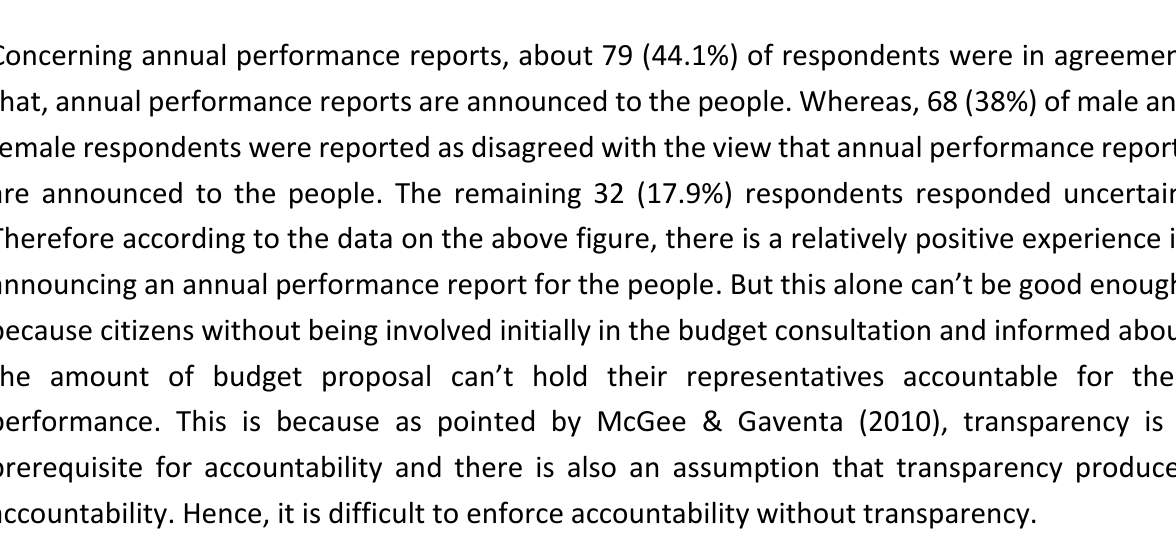
Figure 2: Annual performance reports are announced to the people Source: Survey result, 2019